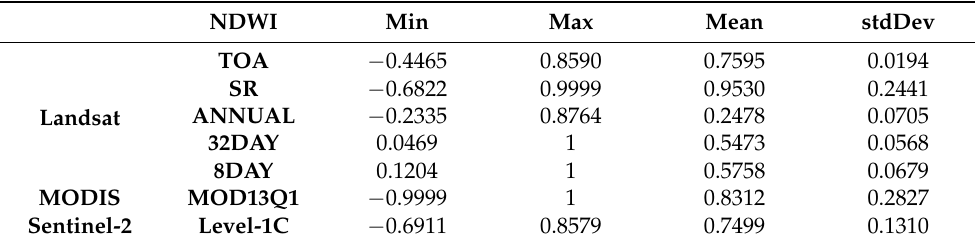
Table 3. Statistical analysis of Landsat images, MODIS images, and Sentinel-2 images.